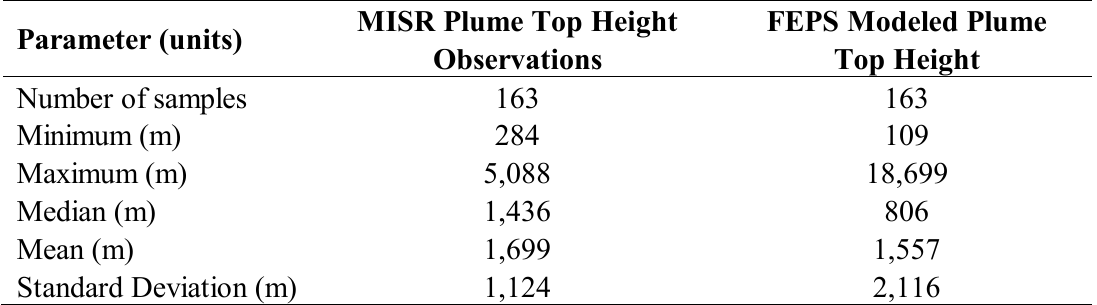
Table 1. Comparison of the overall distributions of observed median wind corrected plume top heights from the MISR instrument and modeled plume top heights from FEPS. Plume height units are meters (m) above ground level.